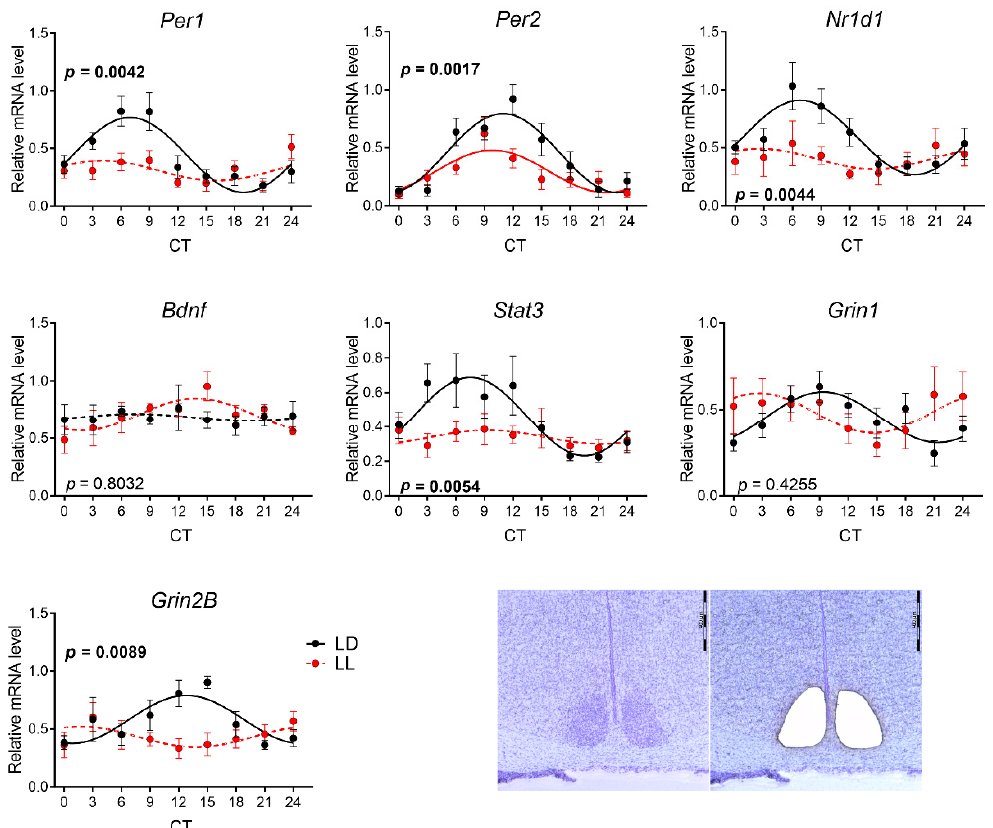
Figure 2. Effect of development under constant light (LL, in red; controls in LD in black) on the rhythmic gene expression in suprachiasmatic nucleus (SCN) at P30. Animals were housed under LL (16 lux) from P0 until P20 and then released into LD conditions. At P30, the animals were sacrificed in 3 h intervals in DD, and the SCNs were sampled by laser dissection and processed by qPCR with specific TaqMan probes. Rhythmicity was proved by cosinor analysis with the horizontal line as zero hypothesis and one-way ANOVA for differences between time groups. Full lines indicate rhythms confirmed by cosinor analysis and one-way ANOVA. Dashed lines indicate profiles not confirmed for rhythmicity by one or both methods. Each point represents the mean ± SEM from six to eight animals. p -values indicate group differences by two-way ANOVA, and significant values are in bold. Representative photomicrographs of coronal sections of SCN (right bottom) demonstrate an area of laser dissection. Scale bar = 400 µm.